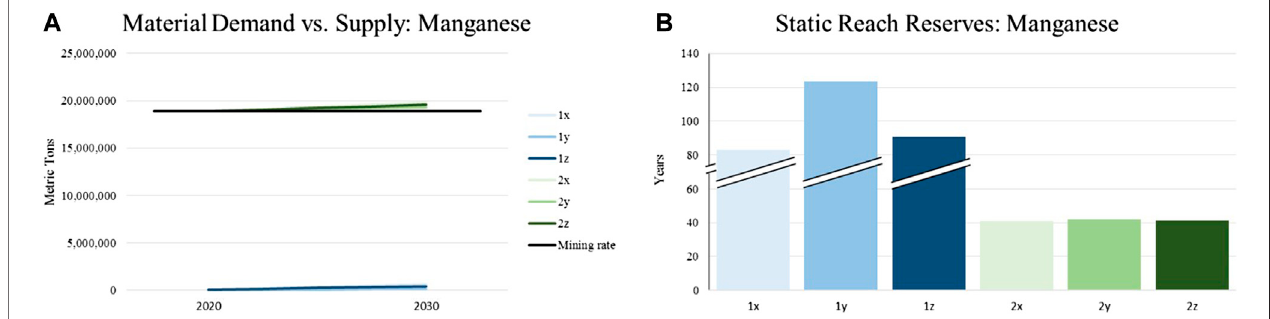
FIGURE 5 | Analysis of manganese raw material